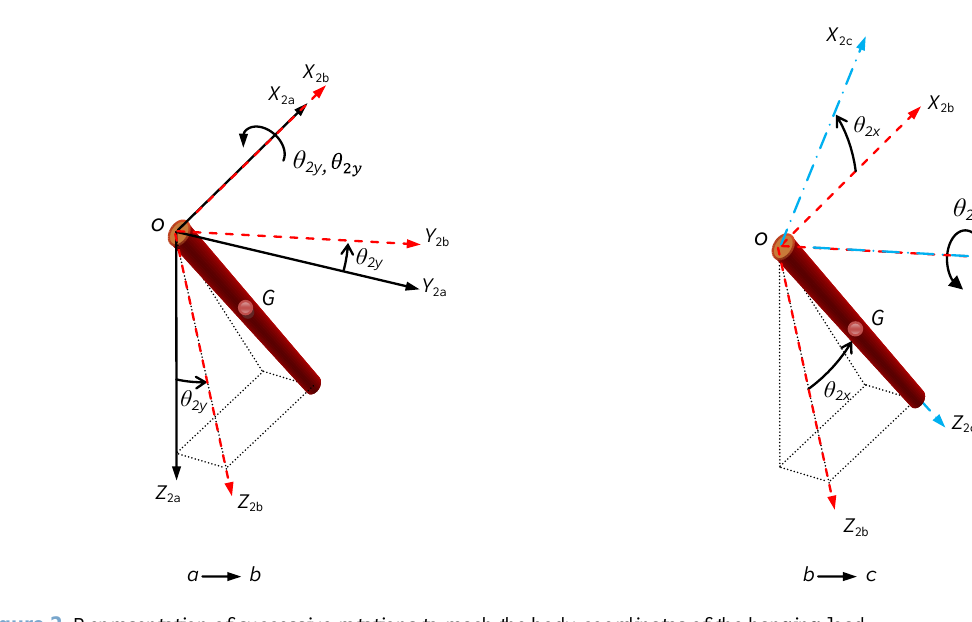
Figure 2. Representation of successive rotations to reach the body coordinates of the hanging load. moves through two rotations about the main axes to become aligned to the load body axis X 2 c Y 2 c Z 2 c . The angular velocity ( ˜ ω ) according to Fig. 2 is defined